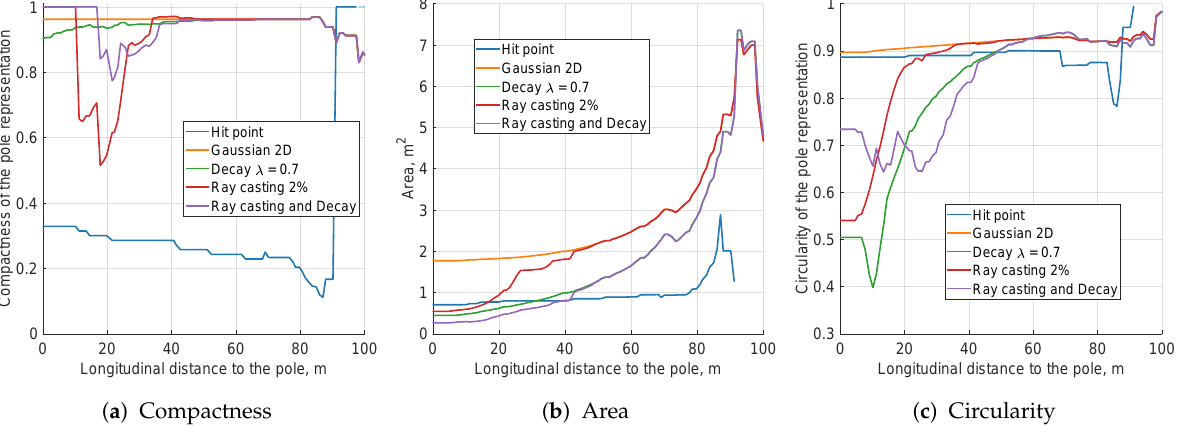
Figure 18. The key performance indicators computed for the experimental data for different variants.